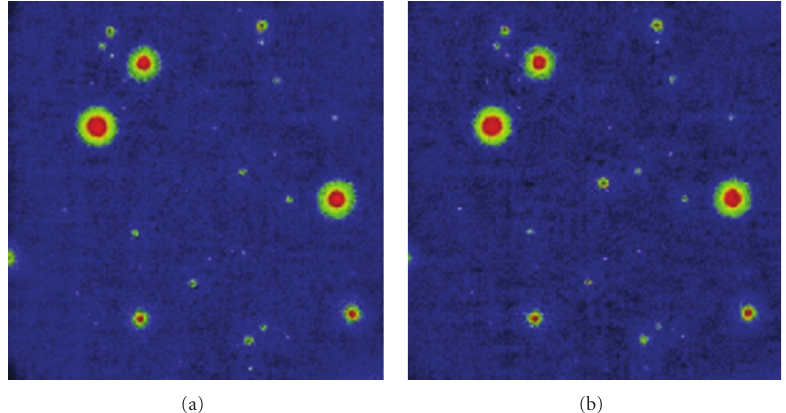
Figure 4: Optical counterpart of GRB 080319B taken by “Pi of the Sky” prototype detector. The prompt optical emission is clearly visible on the right image, taken during the gamma emission at 06:14:03 UT. The prompt emission is no more detectable on the left image, taken 10 minutes after the burst.